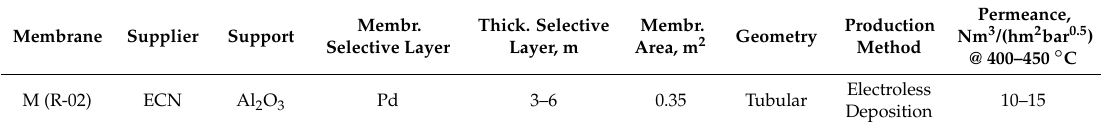
Table 5. Main characteristics of membranes tested under an integrated reactor.